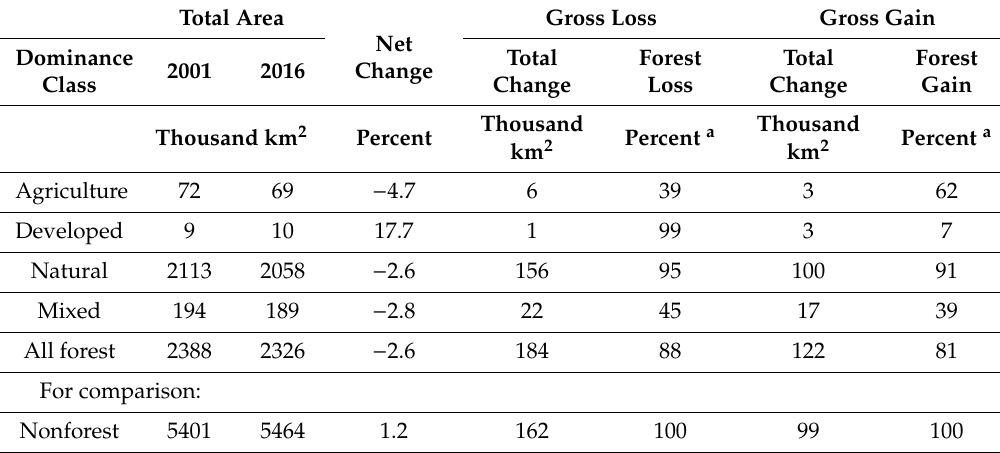
Table 5. Forest area change by landscape dominance class in the continental United States, 2001 to 2016. In addition to the percent of total gross change attributable to forest loss or gain (as shown), the percent of total gross change attributable to the shifting landscape mosaic can be obtained by subtraction from 100. Nonforest statistics are shown for comparison.